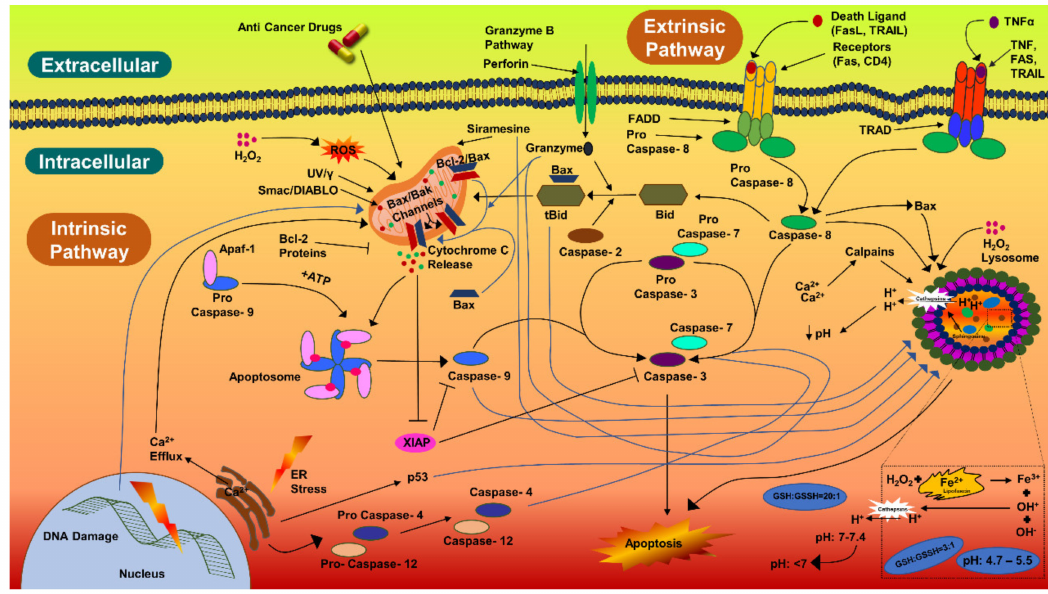
Figure 6. Caspase-3 pathway of cellular